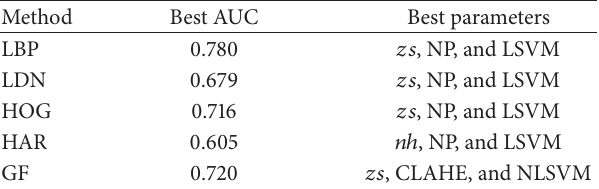
Table 7: Results of the SFS approach.